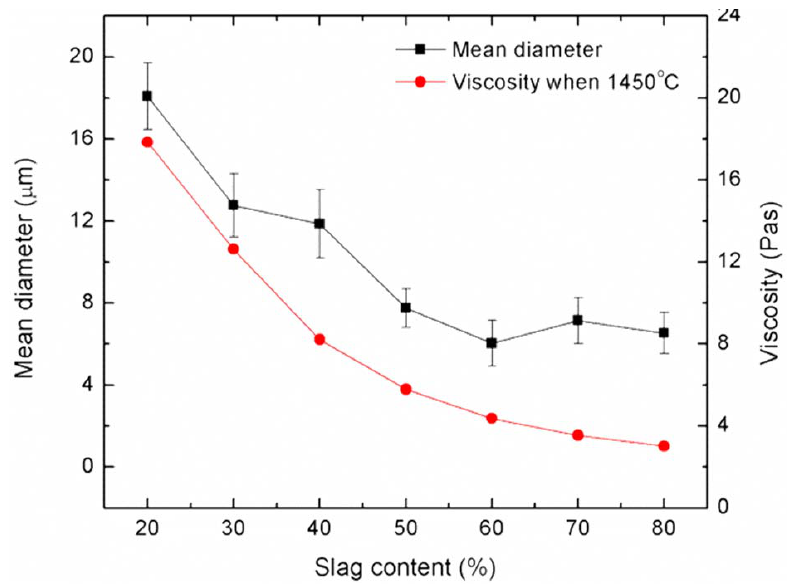
Figure 6. Mean diameter of slag wool